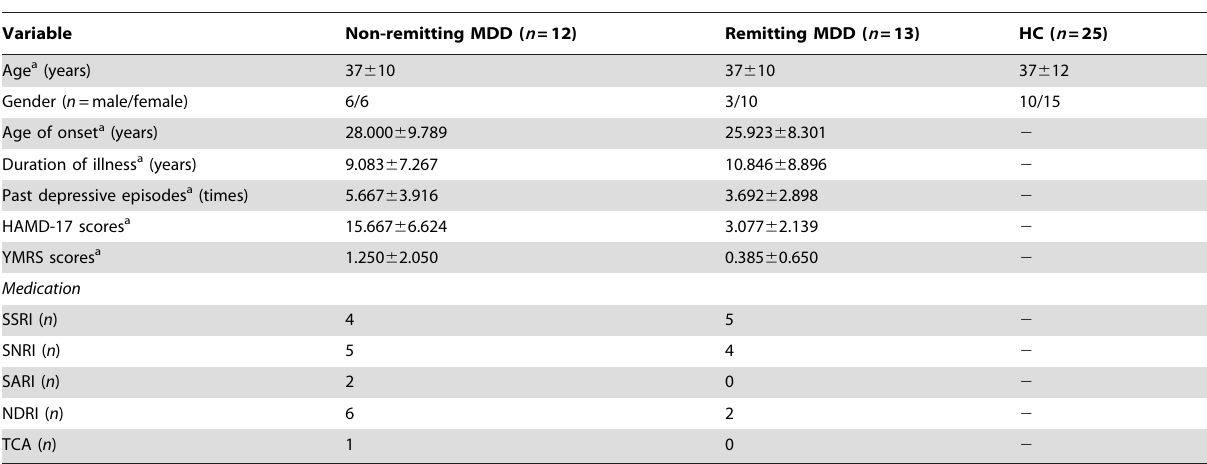
Table 1. Demographic information and clinical